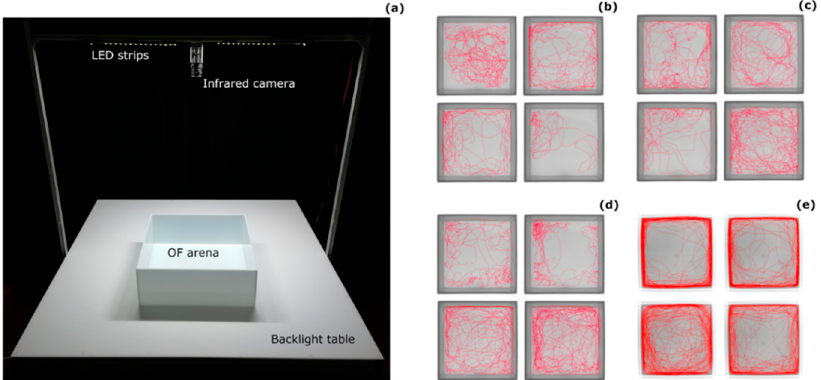
Figure 1. Open-field paradigm for medaka. ( a ) Experimental set up and tracks of 16 randomly-chosen subjects that illustrate differences in the open field behaviour between ( b ) 1 dph, ( c ) 10 dph, ( d ) 30 dph, and ( e ) 120 dph medaka.